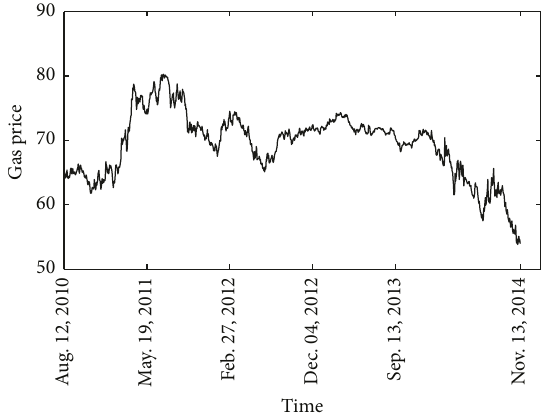
Figure 5: Natural gas futures prices series.